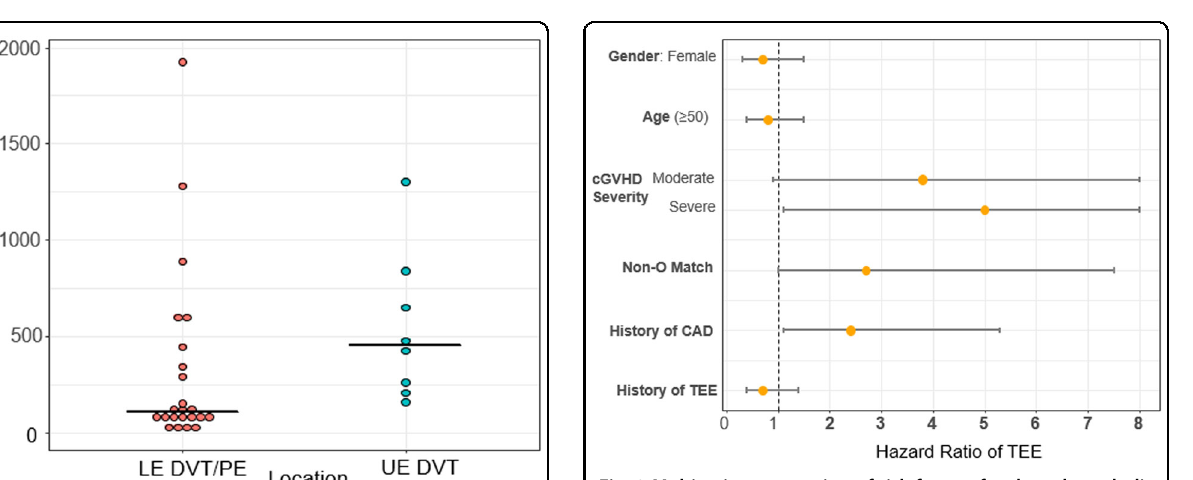
Fig. 2 Multivariate regression of risk factors for thromboembolic event development among all patients with cGVHD. cGVHD = chronic graft-versus-host disease; CAD = coronary artery disease. Non- O match = includes all donor-recipient ABO match other than O to